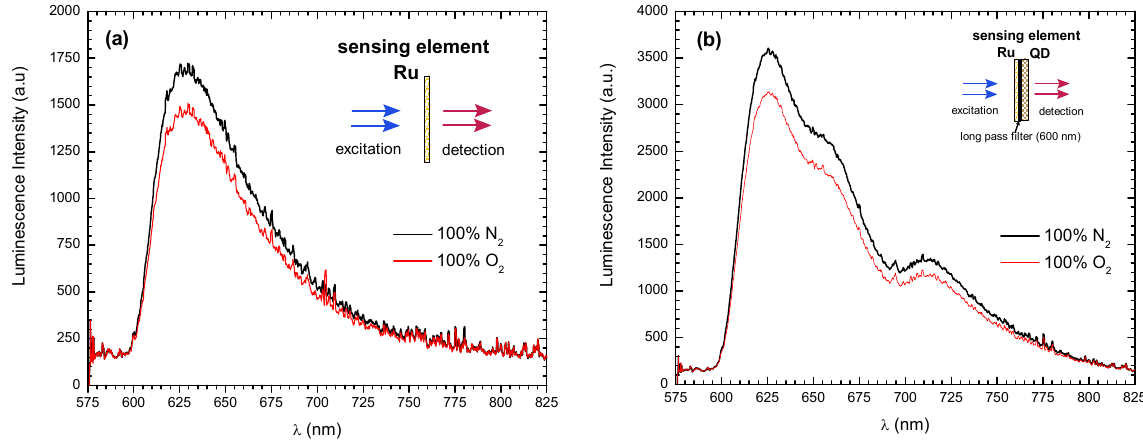
Figure 12. Spectral responses in saturated atmospheres of N configuration): (a) Ru(bpy); (b) Ru(bpy) + long pass filter (600 nm) + QD